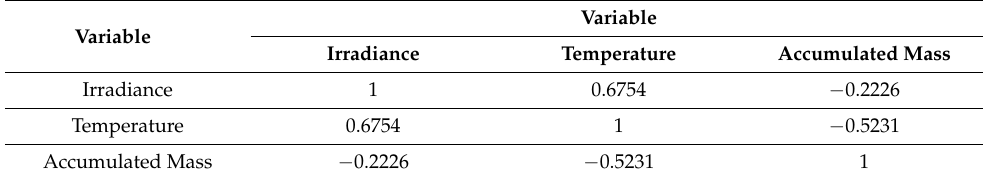
Table 2. The Pearson’s